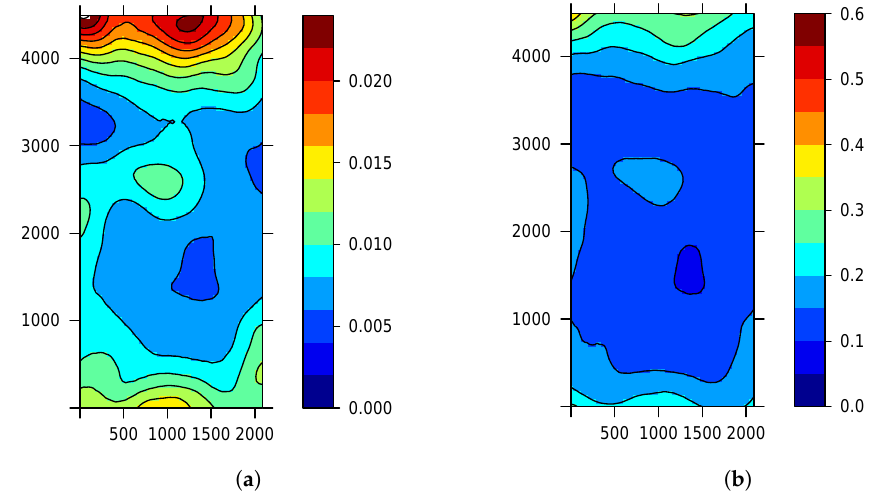
Figure 3. First ( a ) and third ( b ) quartile for π i | Y for the complete